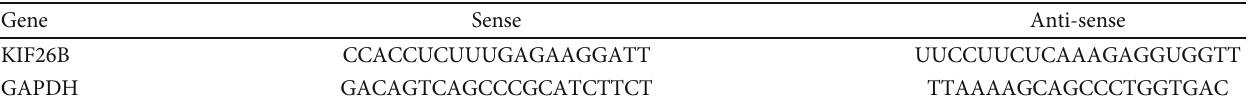
Table 2: All primer sequence used in this